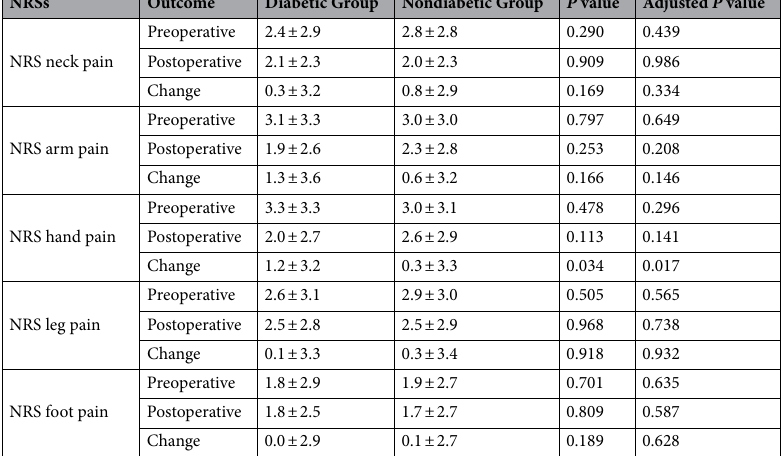
NRSs Outcome Diabetic Group Nondiabetic Group P value Adjusted P